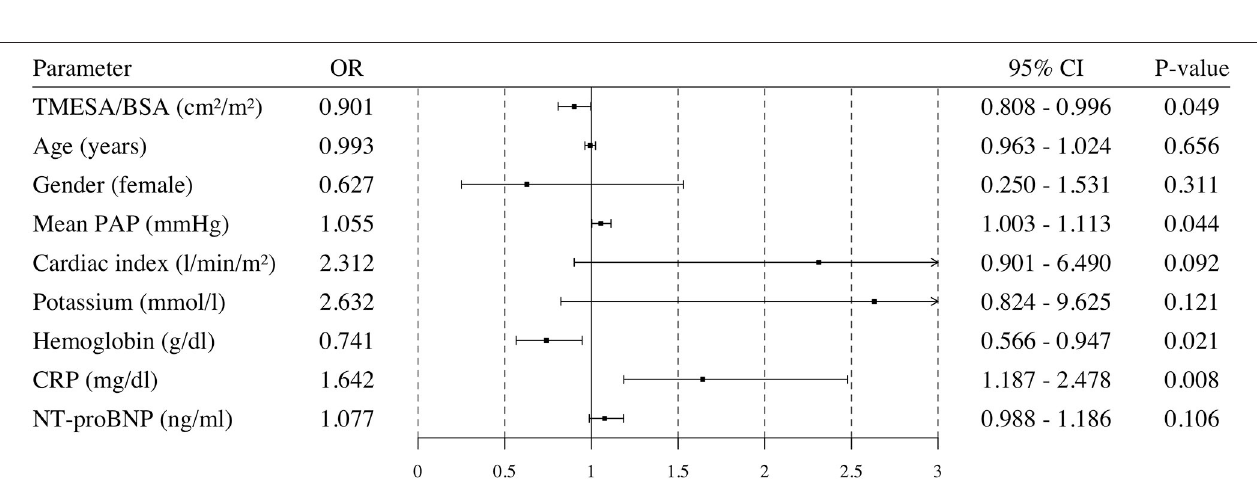
FIGURE 7 | Univariable logistic regression analysis. Odds ratio and 95% confidence interval calculated in a univariable logistic regression analysis for possible risk factors. Endpoint: death or emergency VAD implantation during the HU waiting time. VAD, ventricular assist device; TMESA/BSA, total area of the erector spinae muscles/body surface area; PAP, pulmonary artery pressure; CRP, C-reactive protein; NT-proBNP, N-Terminal Pro-B-Type Natriuretic Peptide; HU, high urgent.